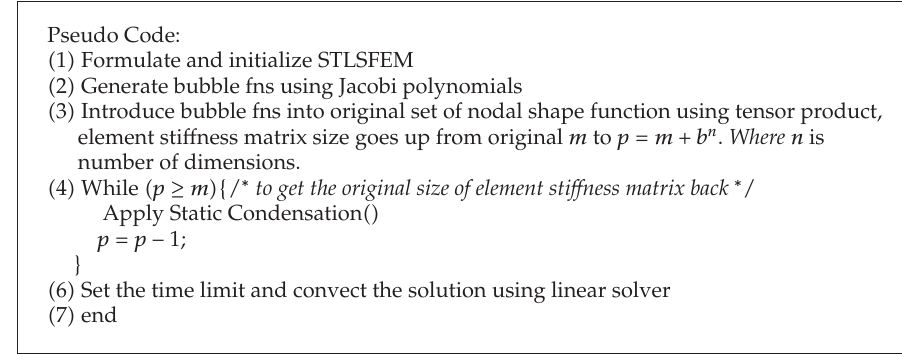
(cid:3) x (cid:4) , 0 < p (cid:4) p − 1